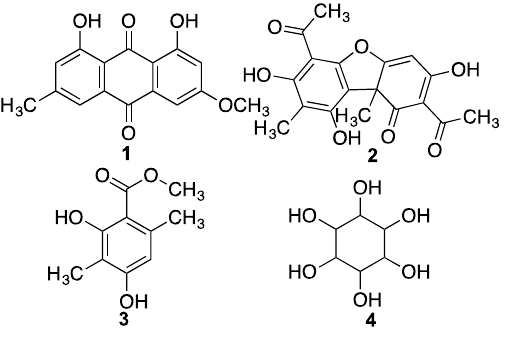
Figure 1. Structures of compounds 1 – 4 isolated from Antartic lichen R. terebrata .